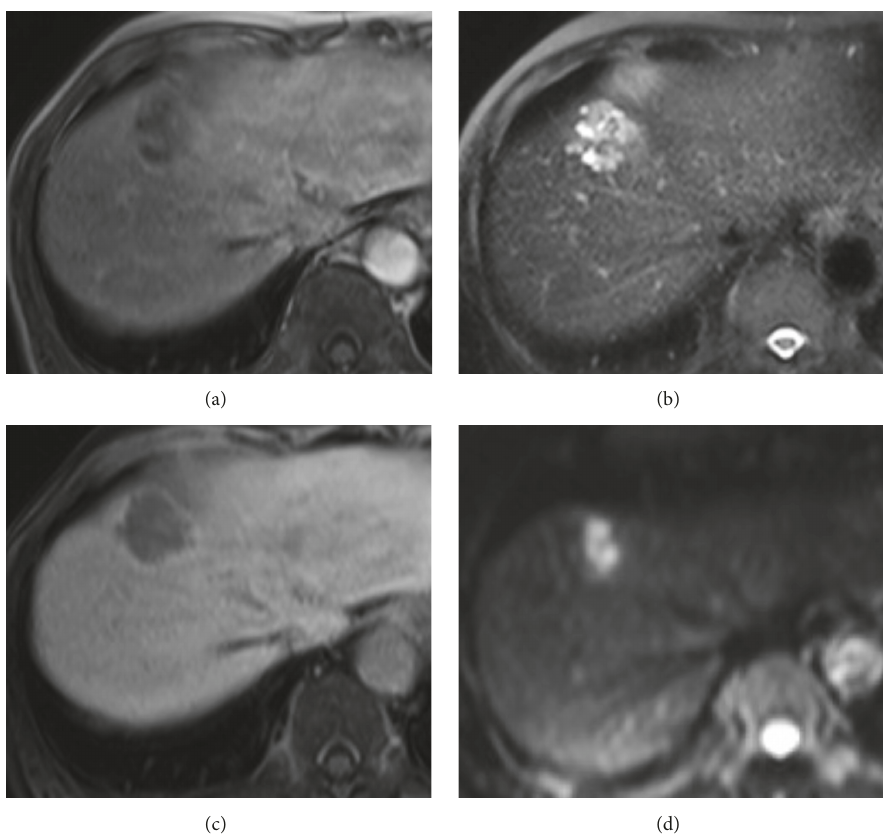
Figure 3: (a) T1-weighted magnetic resonance (MR)images showed thetumor with low intensity with lobulated borders. (b) The T2-weighted MR image shows the low signal portion indicating the cyst wall or bulkhead inside the high signal region. (c) In the hepatobiliary phase, the tumor showed low intensity. (d) On diffusion-weighted images, markedly high intensity was noted.